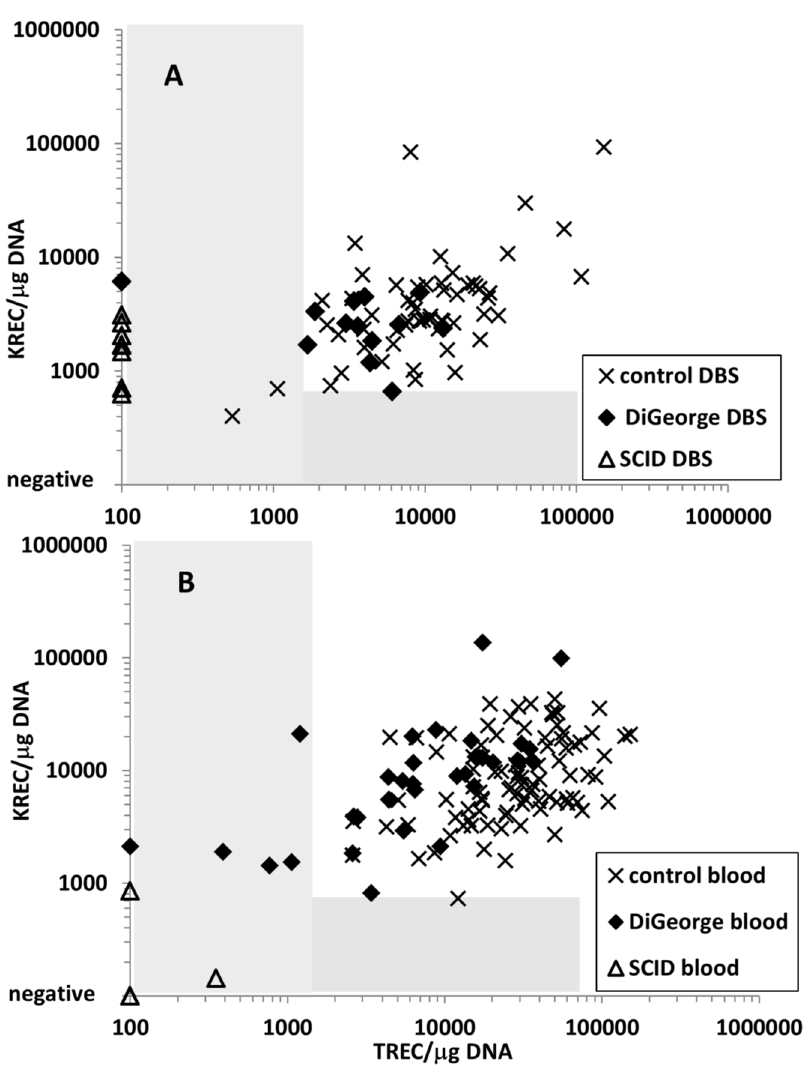
Figure 1. TREC and KREC numbers expressed as copies per microgram of DNA in A) neonatal dry blood spots B) peripheral blood in children (0–18 years) for controls, patients with DiGeorge syndrome and patients with severe combined immunodeficiency (SCID). Grey areas represent the abnormal TREC/KREC range.